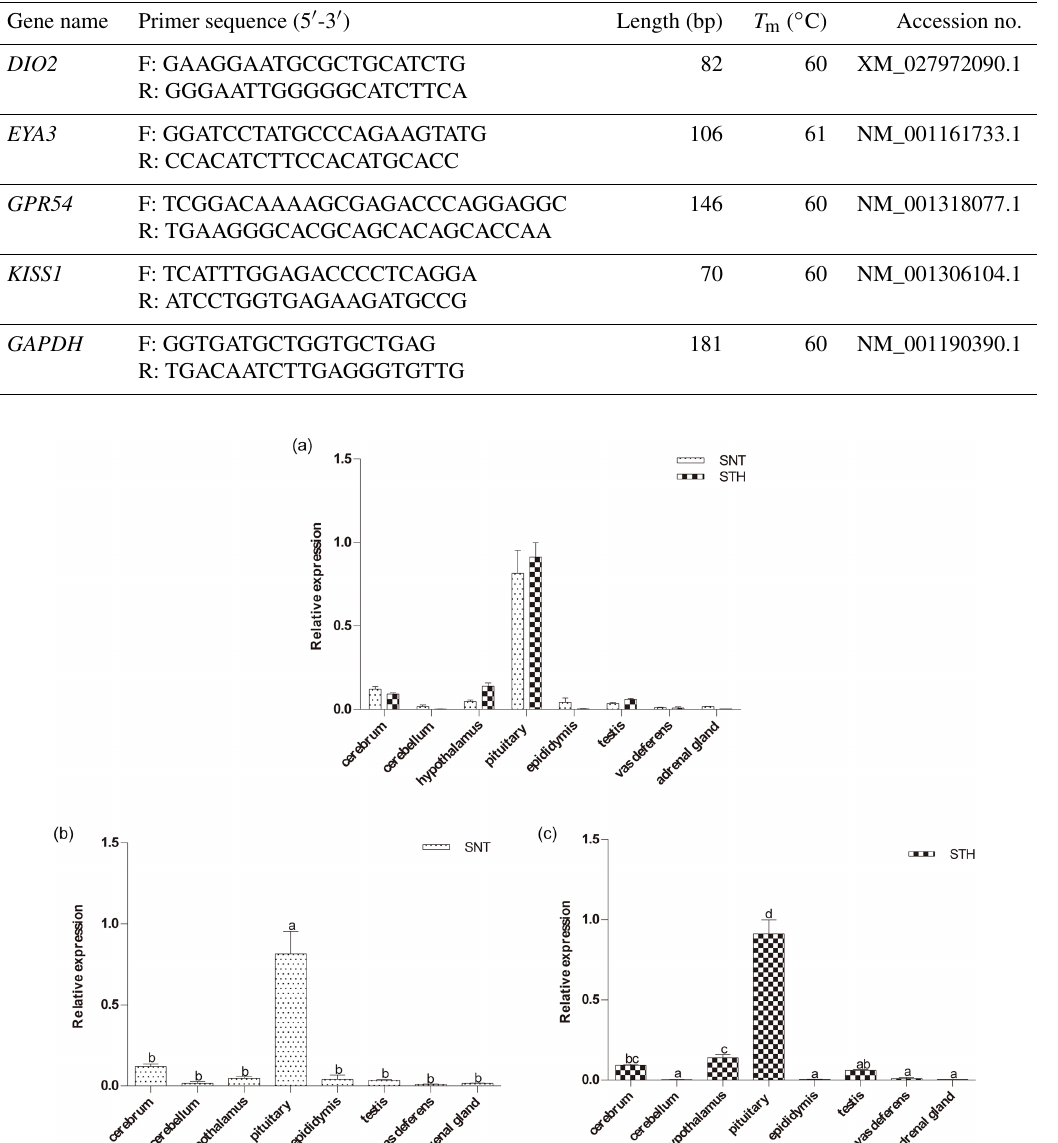
Table 1. Primers of studied genes.